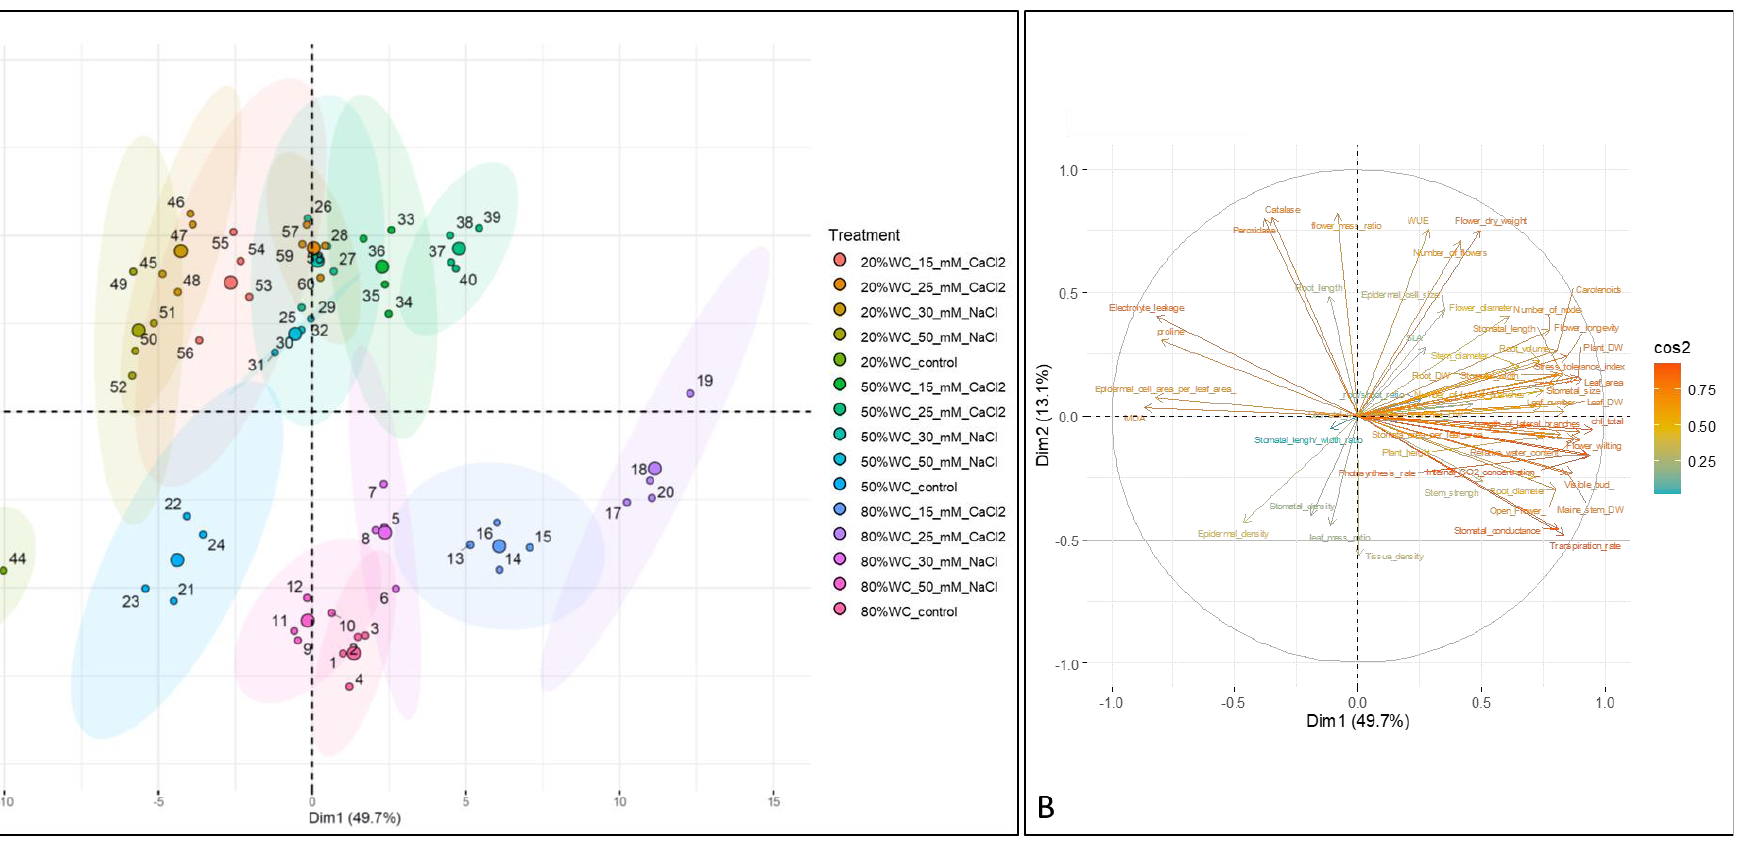
Figure 4. ( A ) Principal coordinate analysis across pre-stress applications [NaCl (0, 30 and 50 mM) or CaCl 2 (15 and 25 mM) via irrigation (five applications at 3 d intervals)] and subsequent watering levels (80, 50 and 20% available water content) in periwinkle cv. ‘Pacifica XP Really Red’. Larger dots indicate mean values calculated from four discrete biological replications. ( B ) The contribution of each trait in the two dimensions is indicated by a gradient scale and color intensity (scale). Vectors near the plot center have lower cos2 values. Narrow angles among variables indicate affinity and wide angles a negative correlation.